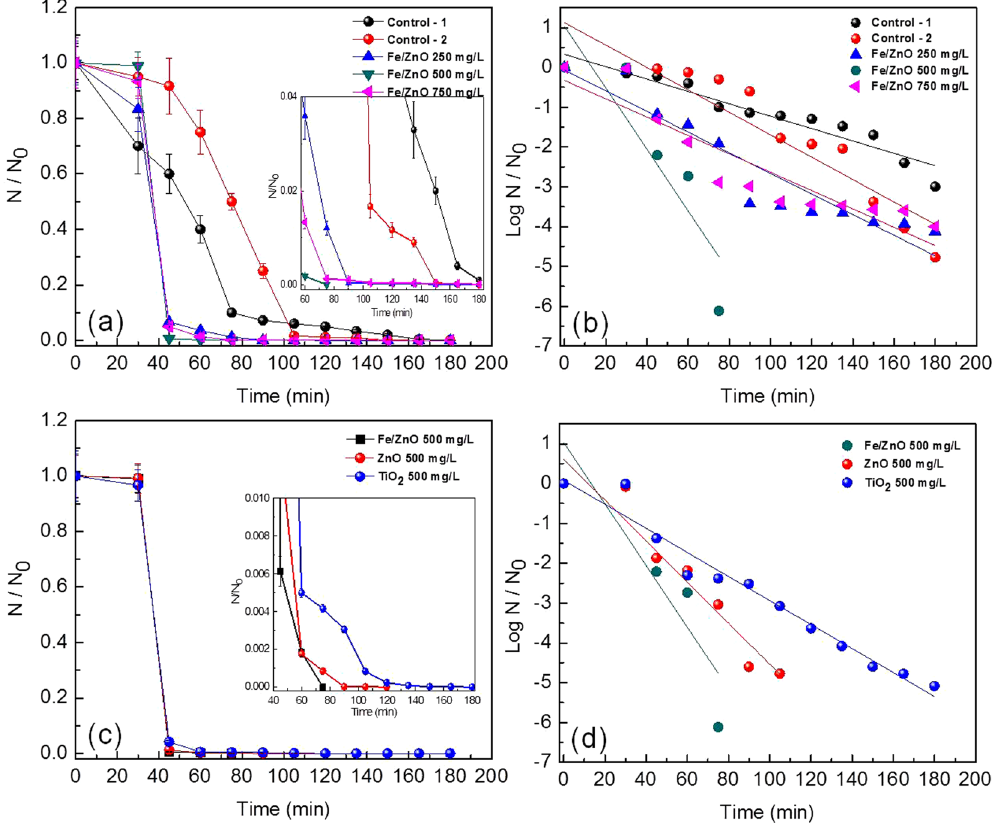
Figure 3. ( a ) Effect of Fe/ZnO NPs loading on the solar-PCD kinetics of MDR E. coli , ( b ) Linear fitting plots of PCD kinetics according to Chick-Watson model, ( c ) Effect of different catalysts on the solar- PCD kinetics of MDR E. coli at a catalyst loading of 500 mg/L, ( d ) Linear fitting plots of PCD kinetics of different catalysts according to Chick-Watson model at a catalyst loading of 500 mg/L. Initial MDR E. coli concentration = 1.2 × 10 7 CFU/mL, Temperature = 35 ± 2 °C, pH = 6.5. Error bars indicate the standard deviation of replicates (n =